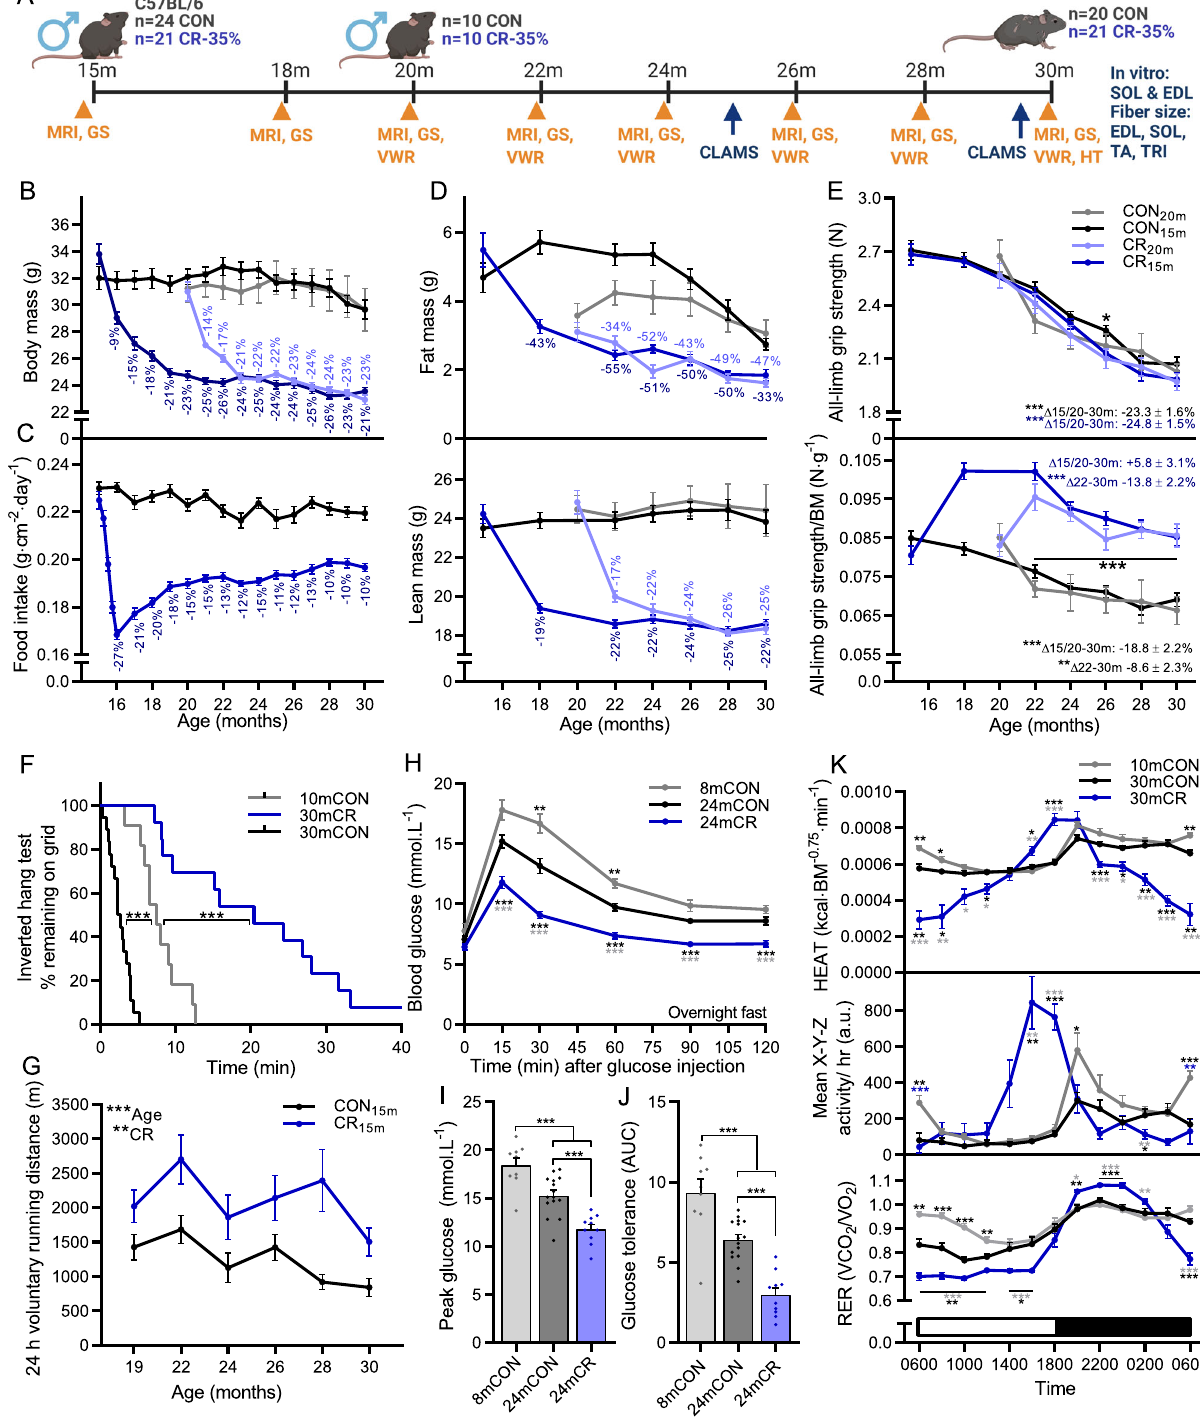
mice, energy expenditure (Fig. 1K upper) and activity (Fig. 1K middle) were tightly restricted to the hours immediately before and immediately after their 5 pm food allocation. Despite displaying characteristic anticipatory increases in activity and energy expenditure prior to food, RER remained at around 0.7 (Fig. 1K lower), indicating almost exclusive fat utilization, before a food- and therefore glucose availability-related increase during night-time hours. In line with lower food intake per body surface area in CR mice (Fig. 1C), mean energy expenditure per